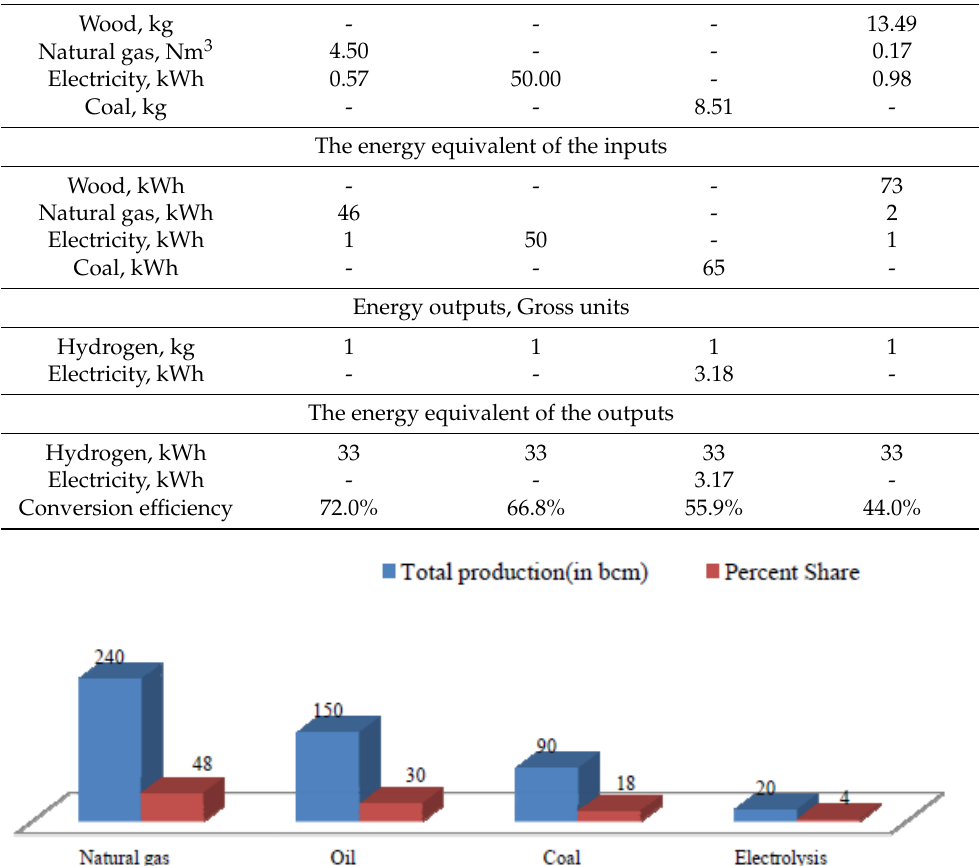
Figure 9. Global hydrogen productions in billion cubic meters.